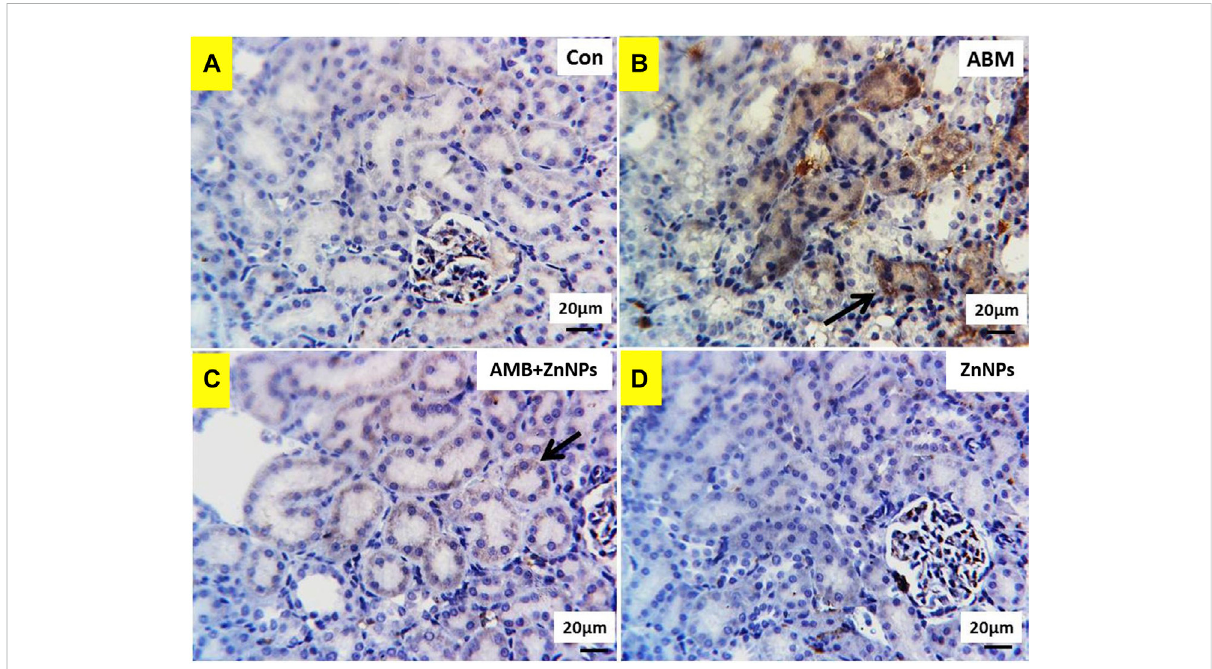
FIGURE 7 Photomicrographs of Cox2 immunohistochemistry staining in kidney showing: (A,D) negative expressions of Cox2 in control (G I) and ZnNPs (G IV), respectively. (B) Massive cytoplasmic immunoreactivity of Cox2 (arrow) in abamectin (ABM; G II) treated rats ’ group. (C) mild to moderate immunostaining of Cox2 (arrow) in ABM + ZnNPs (G III) treated rats ’ group. IHC counterstaining with Mayer ’ s haematoxylin. Scale bar 20 μ